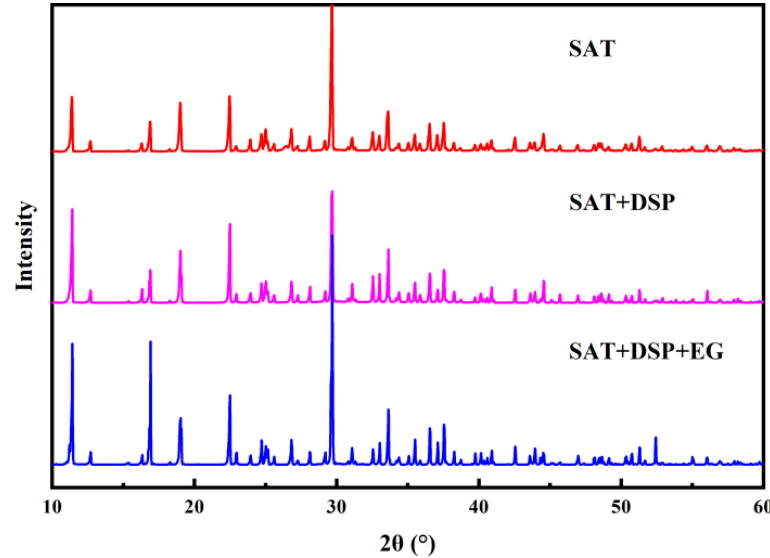
Figure 12. XRD patterns of SAT, SAT/DSP, SAT/DSP/EG.